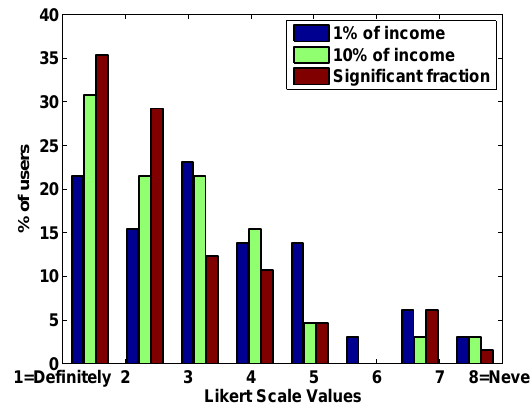
Figure 6. Responses to Brand Recognition and User Awareness Questions (best viewed in color)